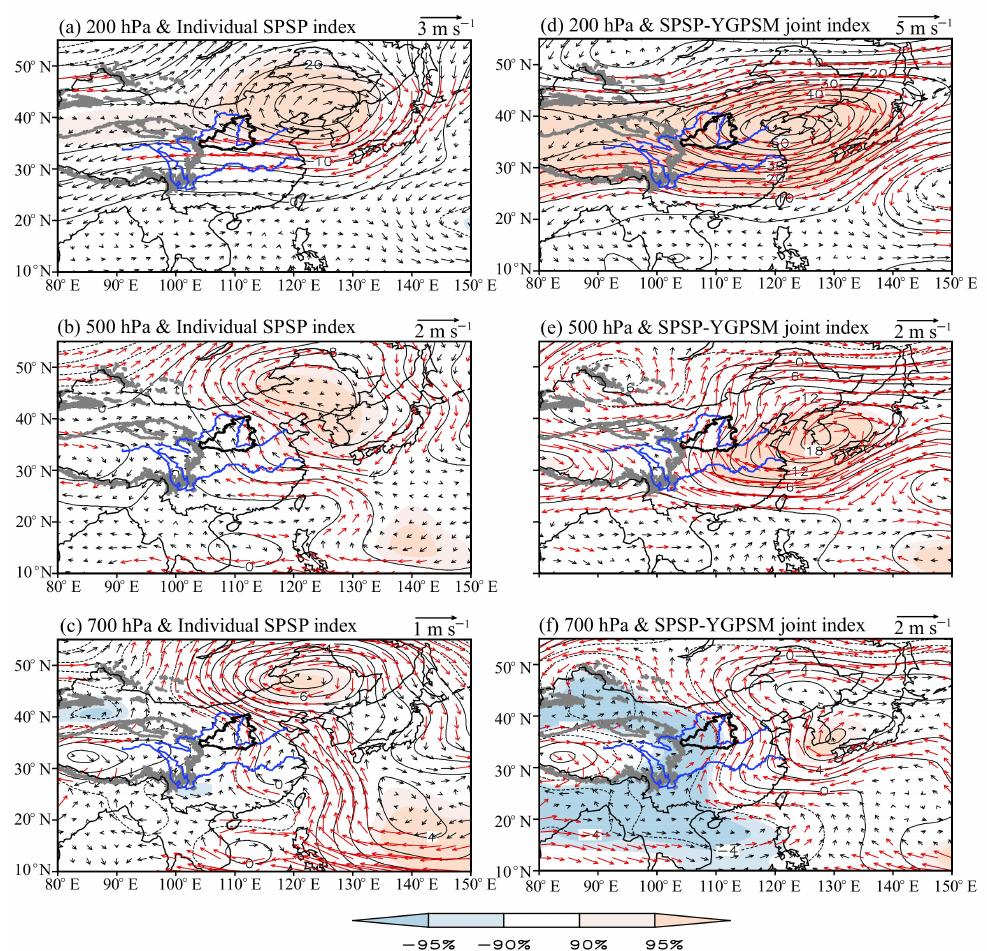
Figure 9. As in Figure 2, but for the anomalies of September geopotential heights and winds ( a , b , c ) obtained by regressing upon the July–August individual SPSP index and those ( d , e , f ) obtained by regressing upon the July–August SPSP-YGPSM joint